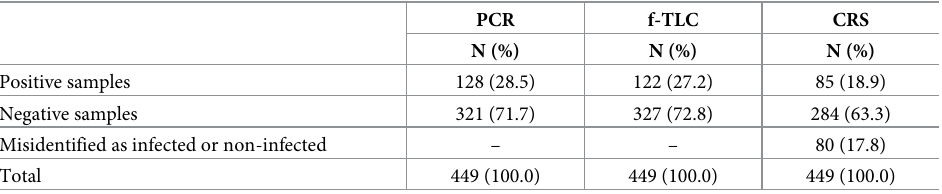
Table 2. Diagnostic results with each